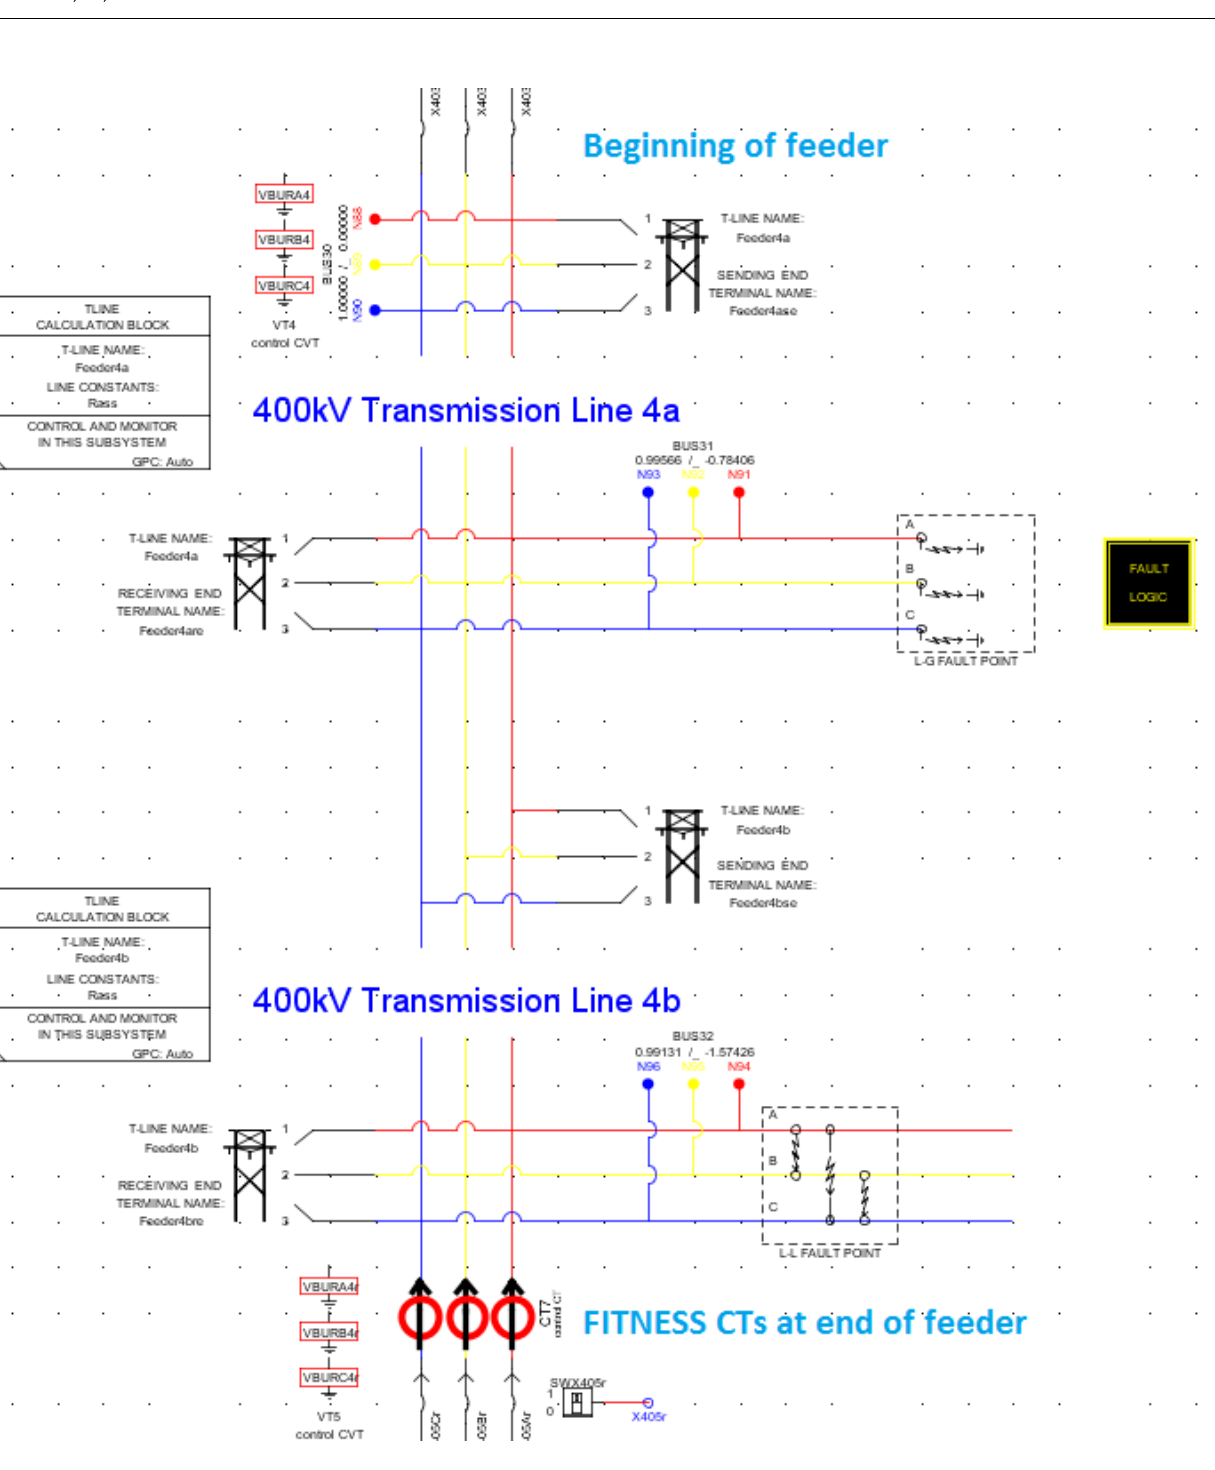
Figure 4. Rassau feeder and connection point of second set of CTs.